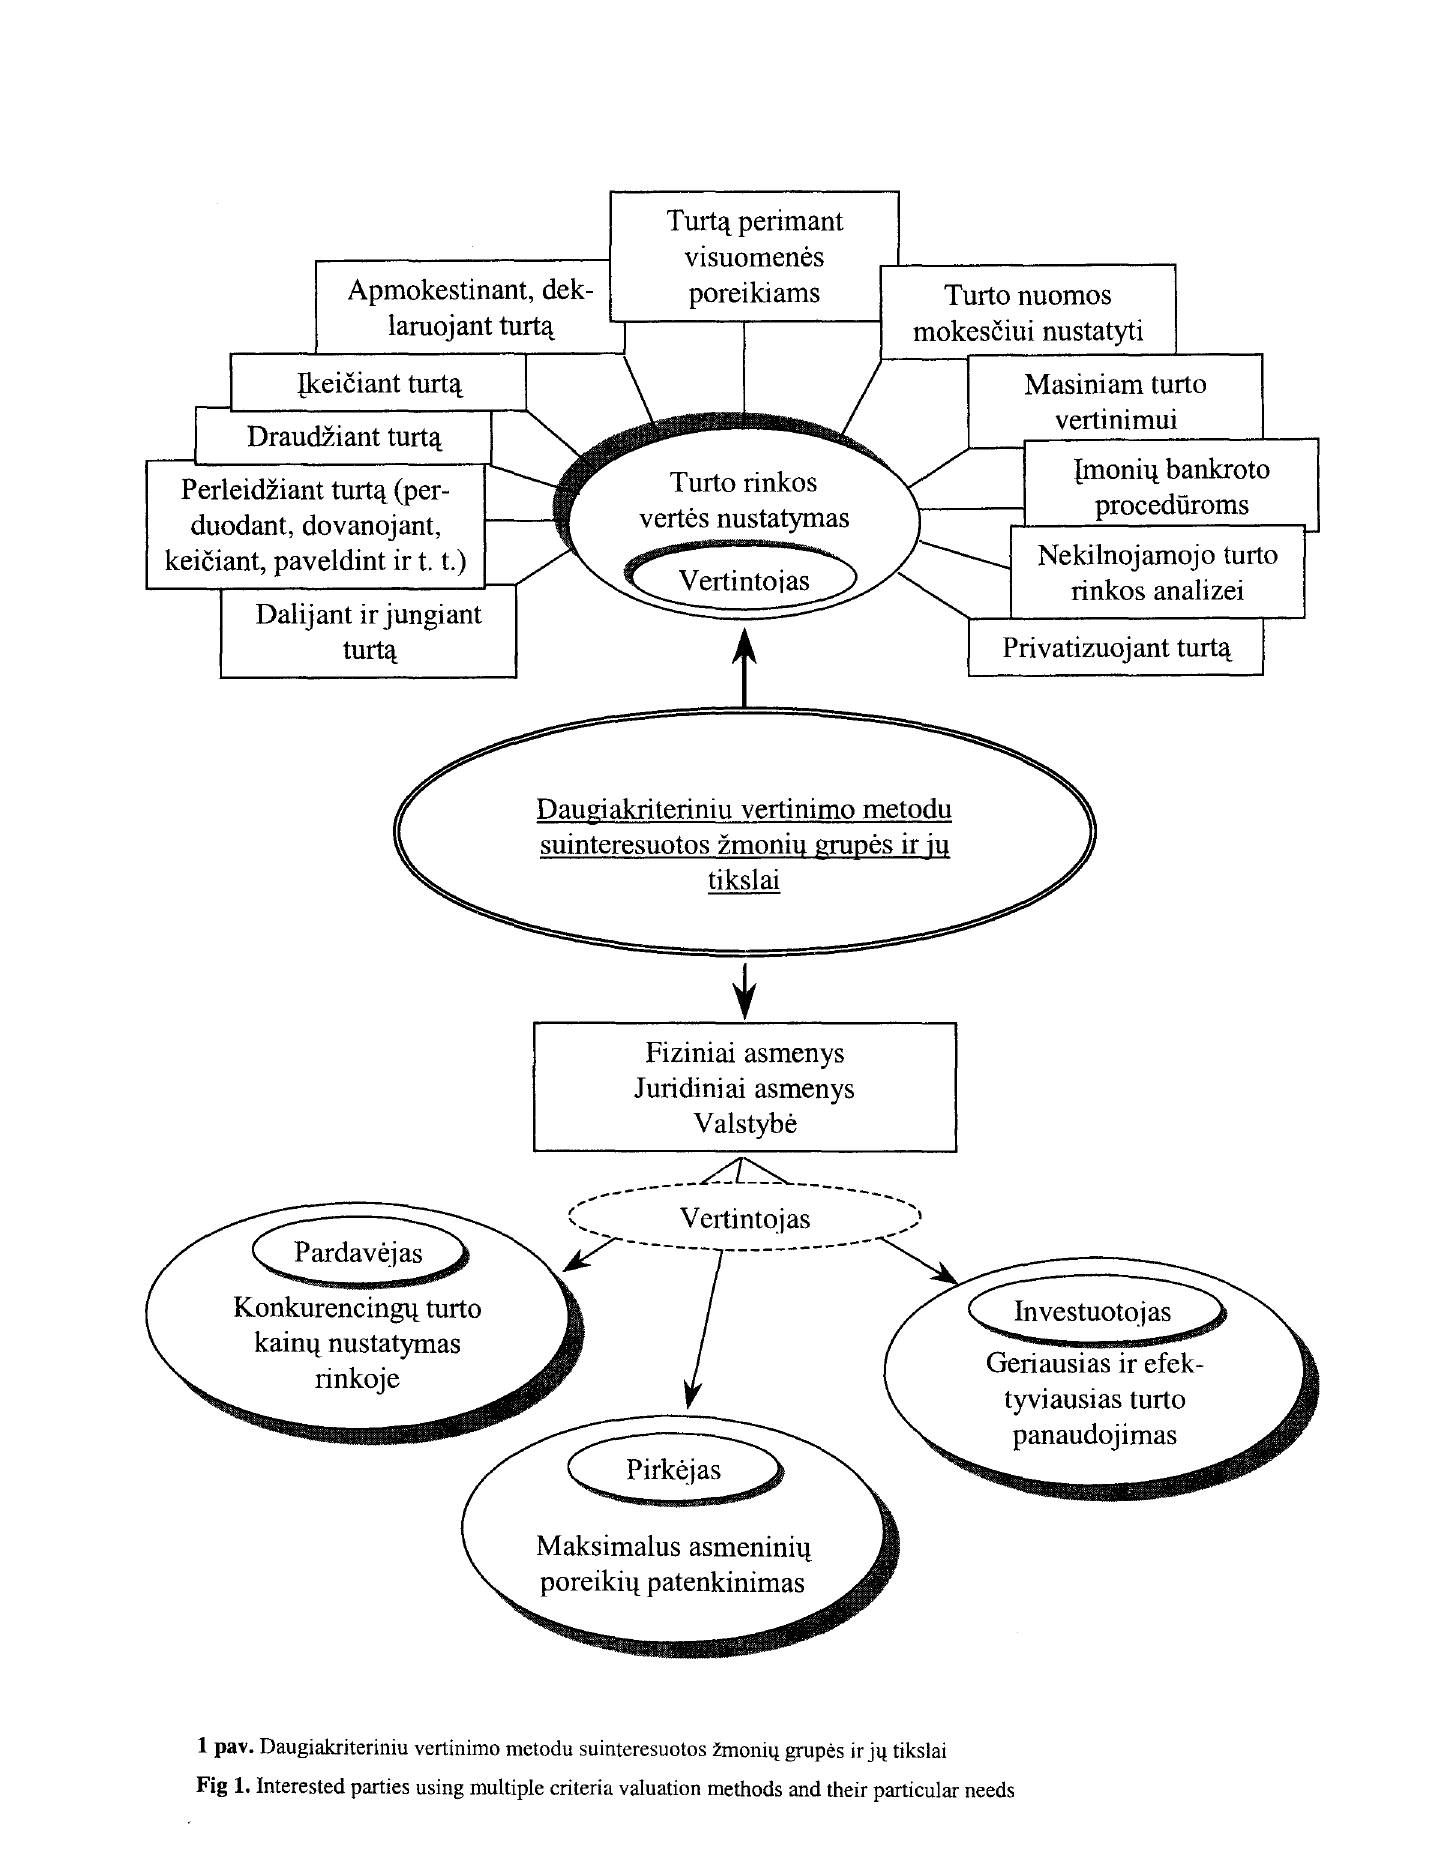
Fig 1. Interested parties using multiple criteria valuation methods and their particular